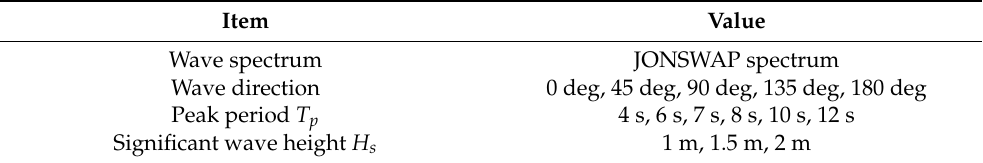
Table 5. Environmental conditions for time-domain